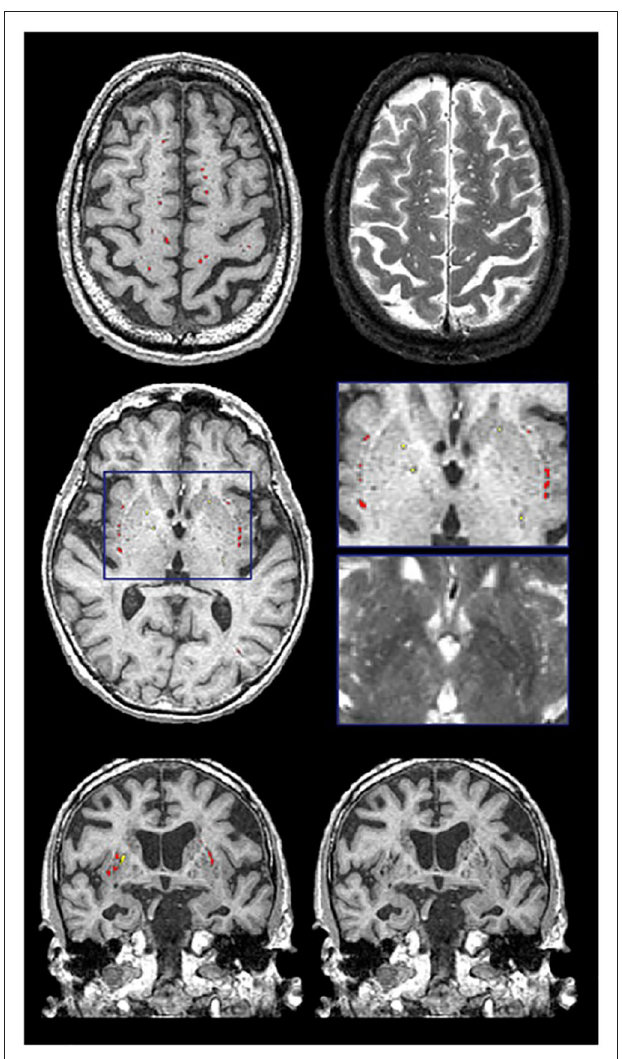
FIGURE 10 | Examples of the PVS segmentation (red and yellow) over-layed onto structural MRI in axial (top 2 rows) and coronal views (bottom row).